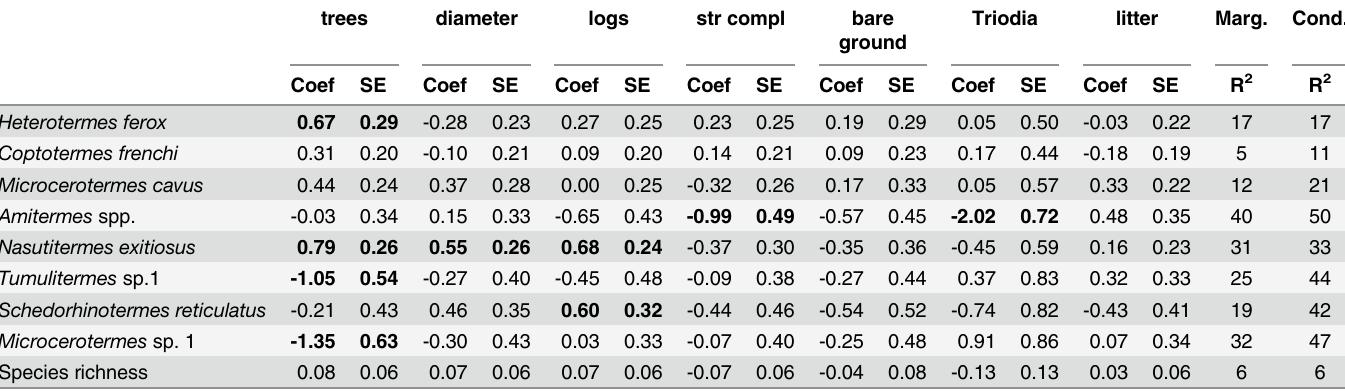
Table 5. Summary of generalised linear mixed models of the occurrence of termite species at the site scale. Coefficients of important explanatory variables (and standard errors) shown in bold are those for which the 95% confidence intervals of model-averaged coefficients did not include zero. Marginal and conditional R 2 values indicate the model fit of the full model (all variables). Descriptions of explanatory variables are given in Table